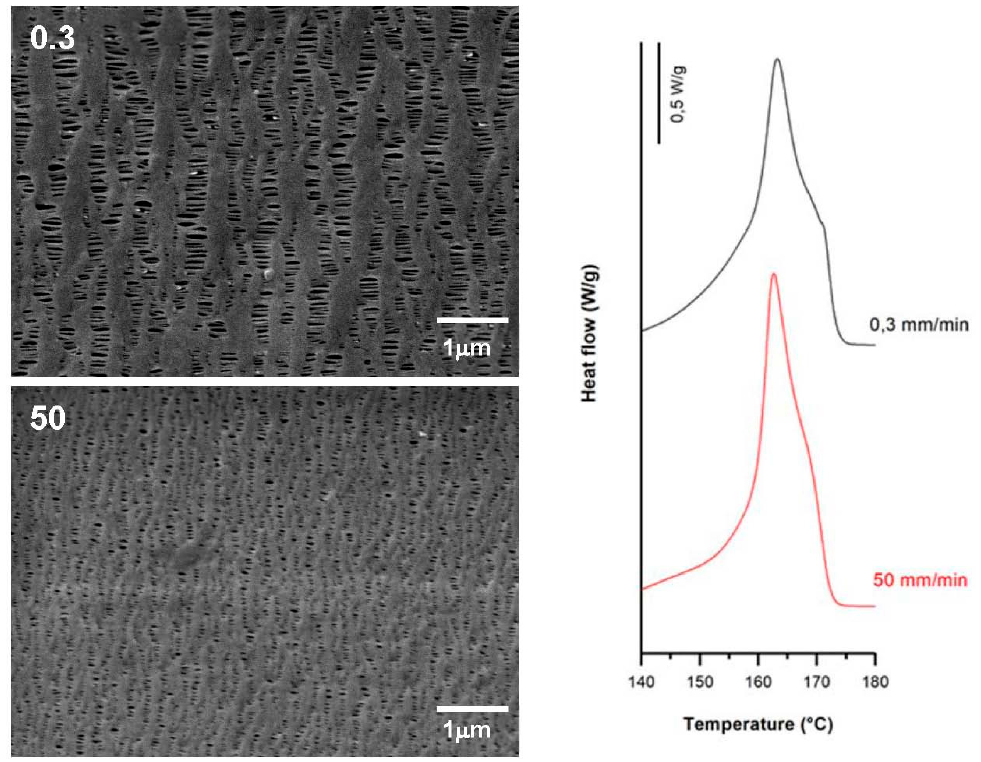
Figure 10. Influence of hot strain rate (upper-left, in mm/min). Common uniaxial strain conditions. Cold stage, 0.3 mm/min, 20%; hot stage, 130%.